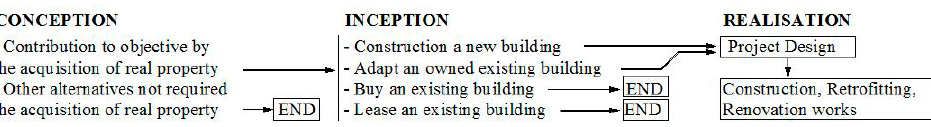
Fig. 3. Project management phases for acquisition of real